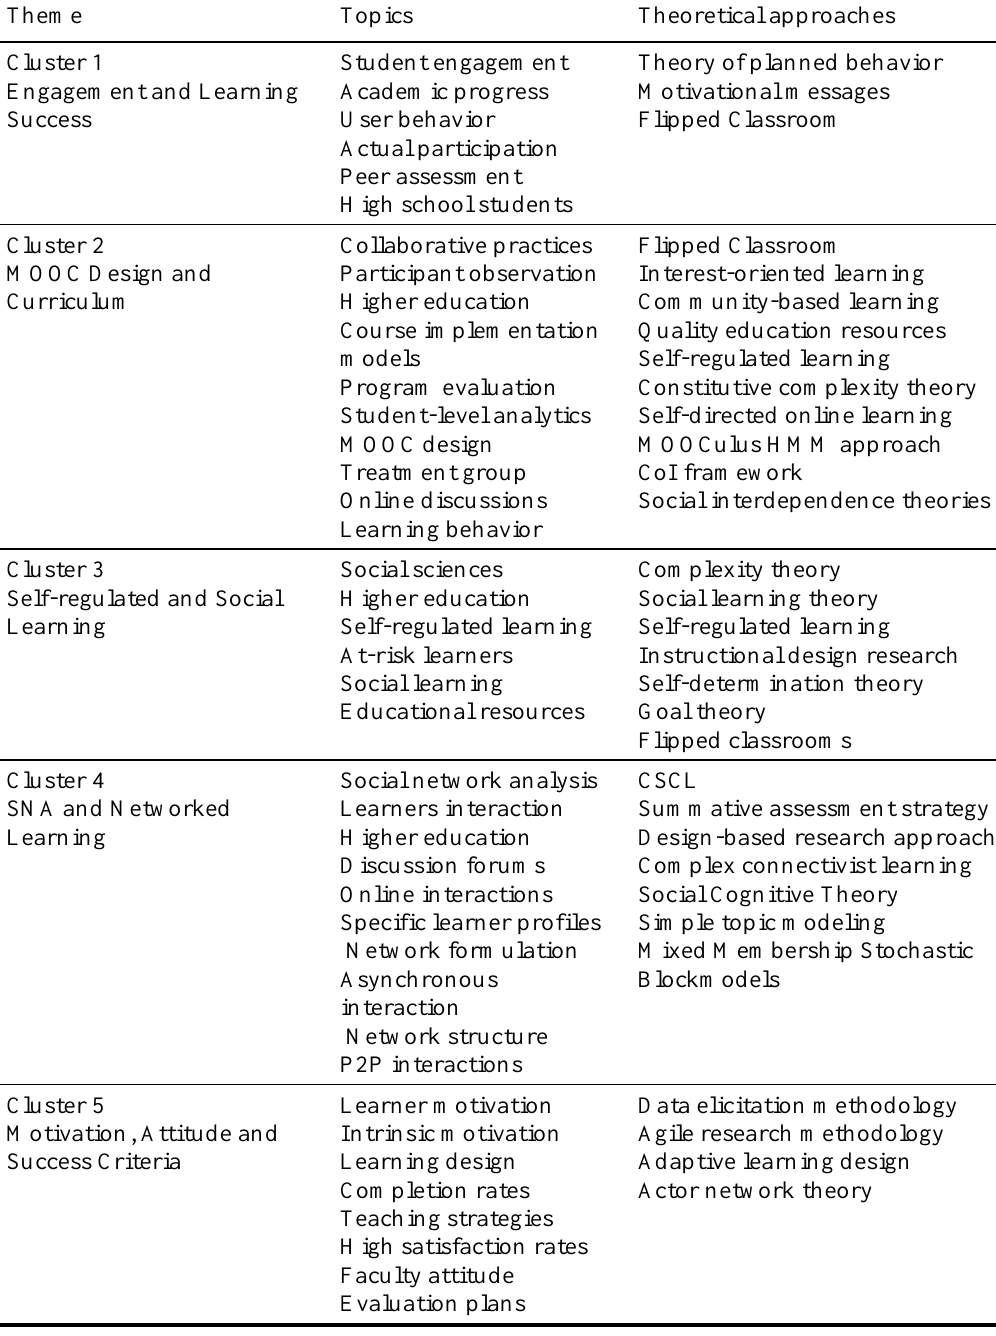
Table 10 Phase 2 Topics and Theoretical Approaches of Discovered Research Themes Theme Topics Theoretical approaches Cluster 1 Engagement and